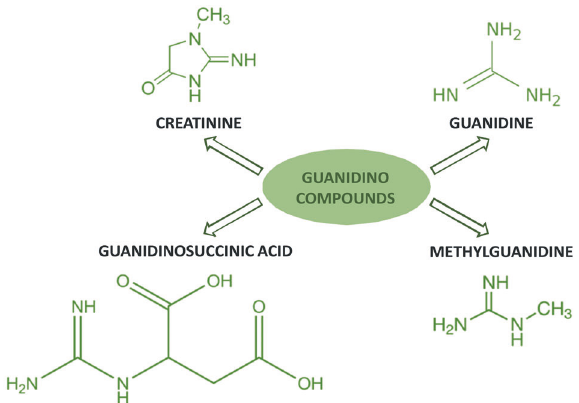
Fig. 1 Guanidino compounds (GCs). Molecular representation of creatinine, guanidine, guanidinosuccinic acid, and